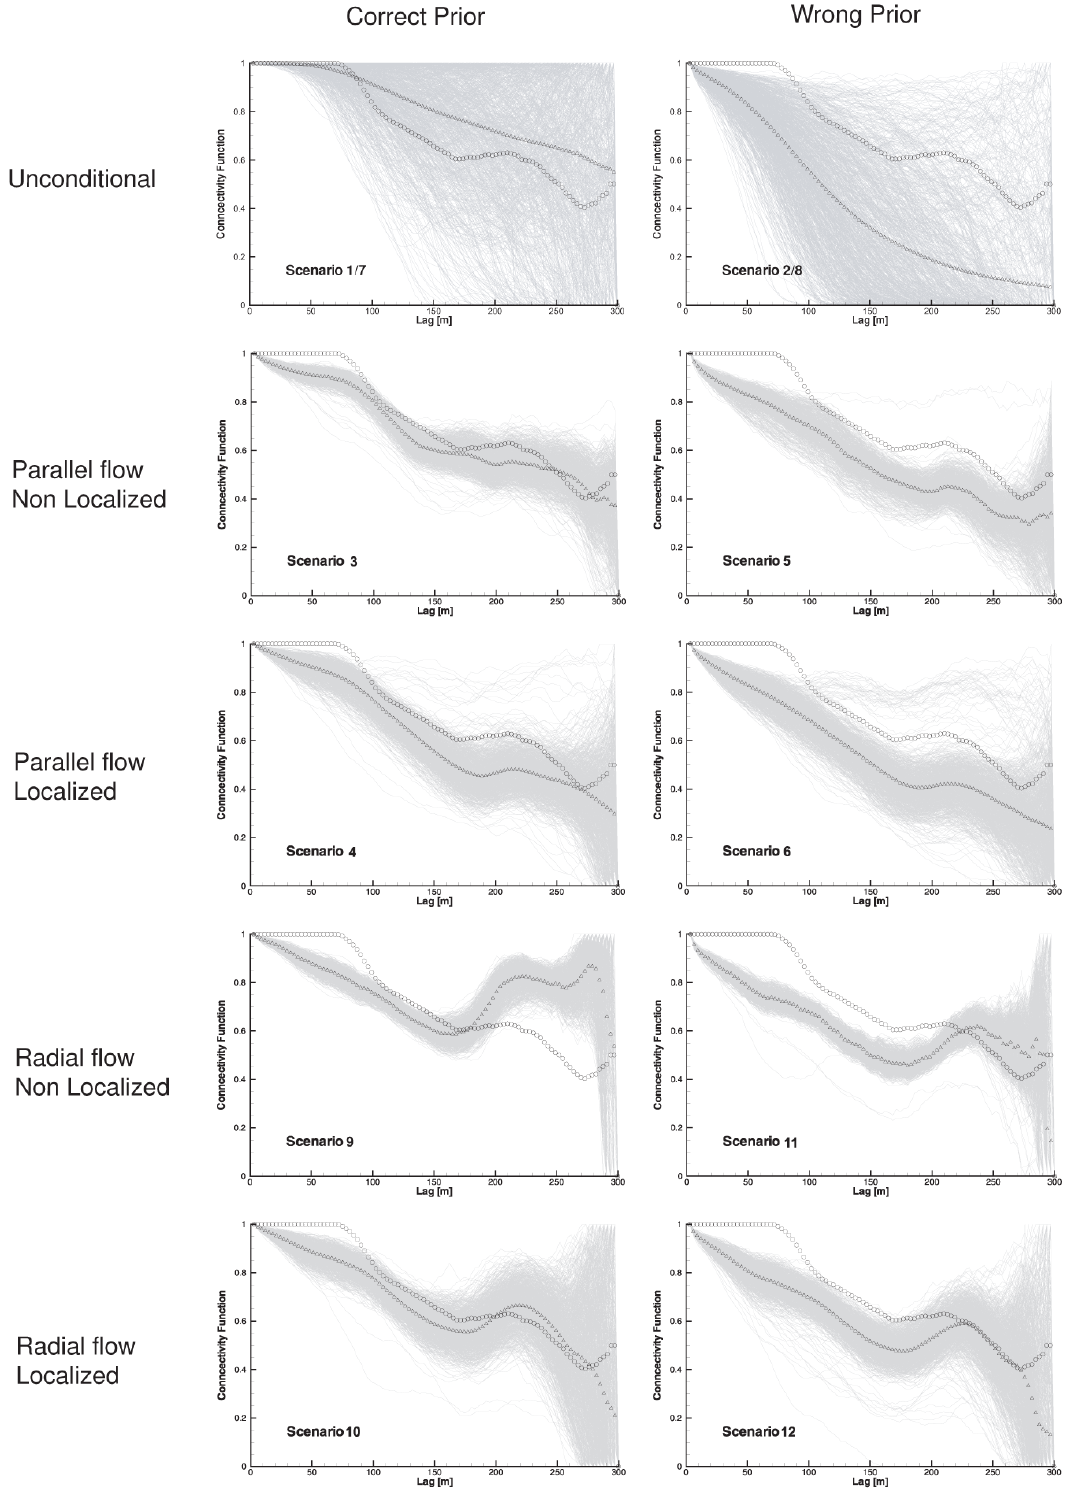
Fig. 8. Connectivity function of logconductivity fields at time step nT =60 for the different scenarios. Gray curves correspond to individual realizations, their mean is given by the triangles and the circles correspond to the